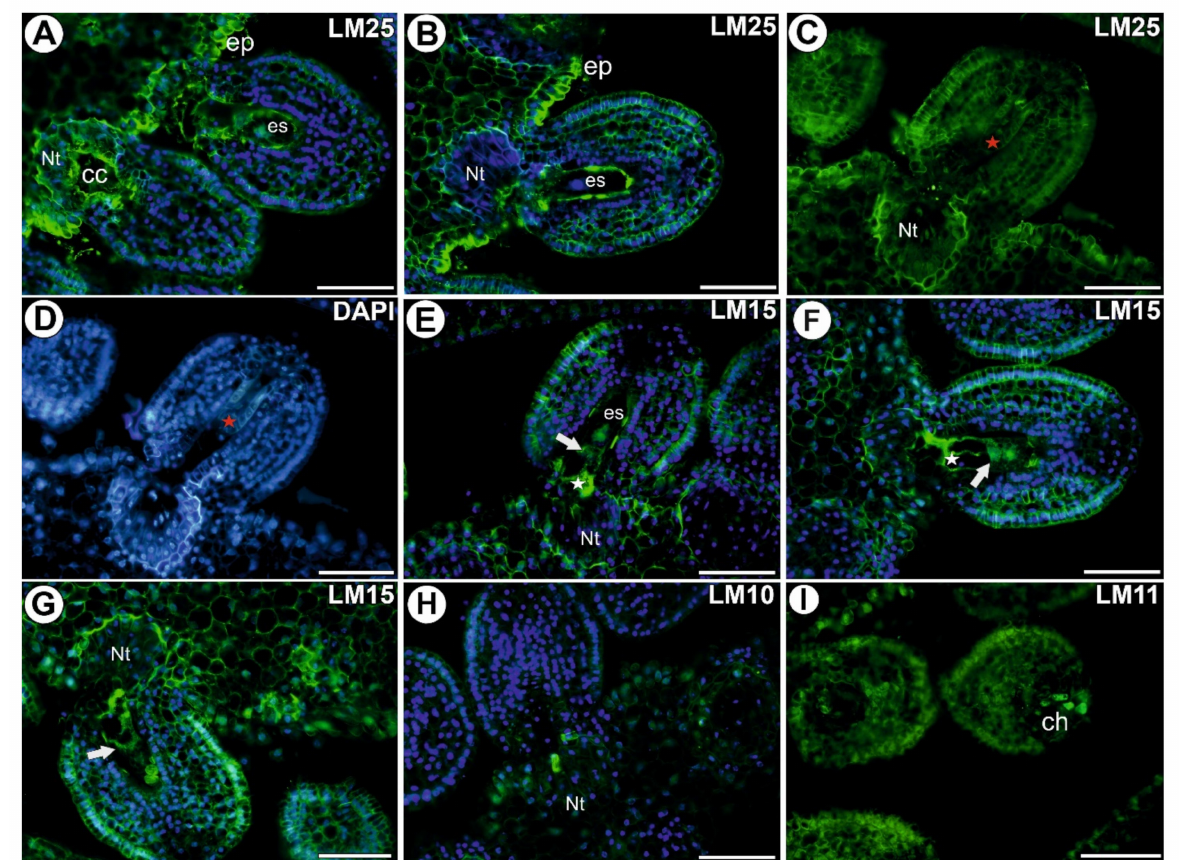
Figure 3. Xyloglucan detected in an ovule of Utricularia nelumbifolia before pollination (Antibodies– green fluorescence). ( A , B ) Xyloglucan (labeled with LM25) detected; note the intense signal in the epidermis of the placenta (ep); embryo sac (es), hypertrophied part of the central cell (cc), placental nutritive tissue (Nt), bars 50 µ m. ( C , D ) Xyloglucan (labeled with LM25) detected, ovule without a female gametophyte; note the persistent epidermis of the nucellus (red star); placental nutritive tissue (Nt), bars 50 µ m. ( E – G ) Xyloglucan (labeled with LM15) detection; note the intense signal in the synergids (white star), egg cell (white arrow); embryo sac (es), placental nutritive tissue (Nt), bars 50 µ m. ( H ) Xylan (labeled with LM10) detected; placental nutritive tissue (Nt), bar 50 µ m. ( I ) Xylan/arabinoxylan (labeled with LM11) detected; note the positive signal at chalaza (ch), bar 50 µ